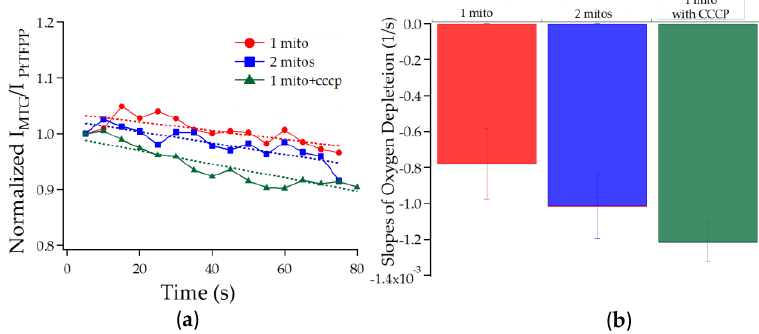
Figure 4. ( a ) Plotted PtTFPP normalized phosphorescent intensity from chambers with one mitochondrion, with two mitochondria, and with one mitochondrion treated with CCCP. Data points were averaged every 5 s; ( b ) The slopes of the fitted lines in ( a ) are plotted. Results indicated that the rates of oxygen depletion in the corresponding microchambers. The errors were obtained from fitting the data.